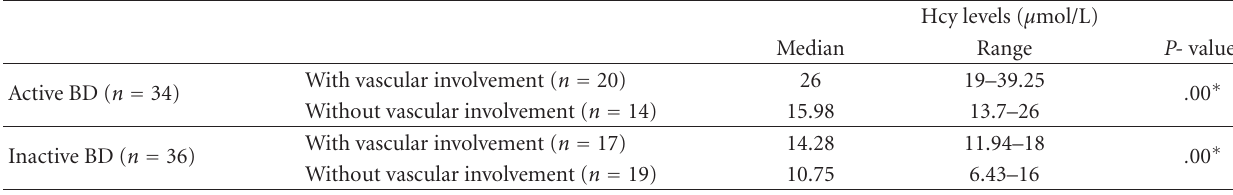
Table 8: Comparison of Hcy intragroups of active and inactive patients according to presence of vascular involvement.